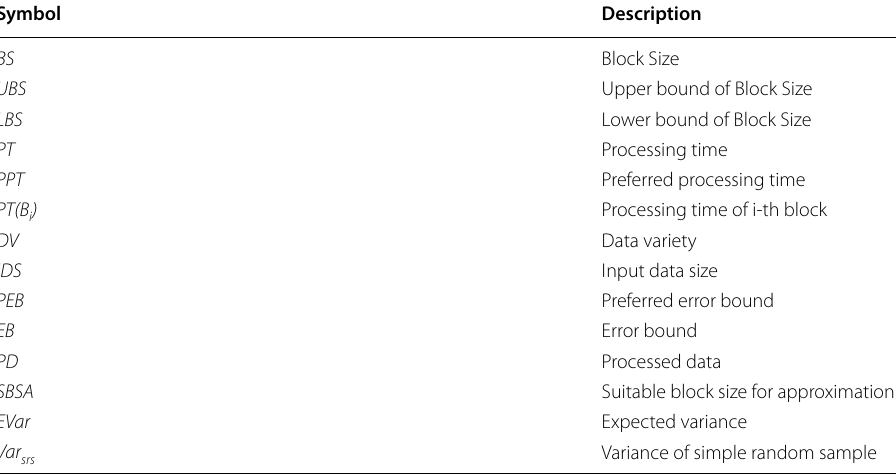
Table 1 Our notations in our algorithm